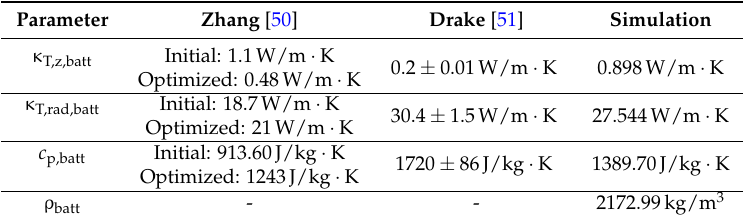
Table 1. Effective thermal parameter used in simulation in comparison with effective thermal parameter given in literature.